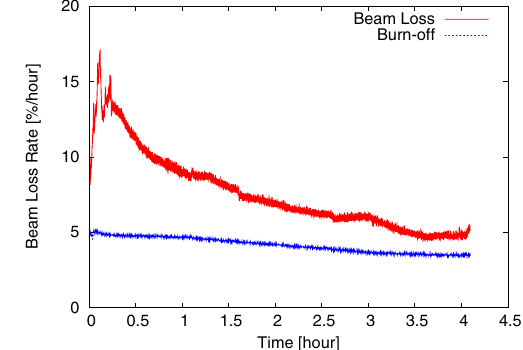
FIG. 2. One example of nonluminous beam loss of the Au beam with longitudinal and vertical cooling in the Yellow ring in the 2011 100 GeV Au-Au